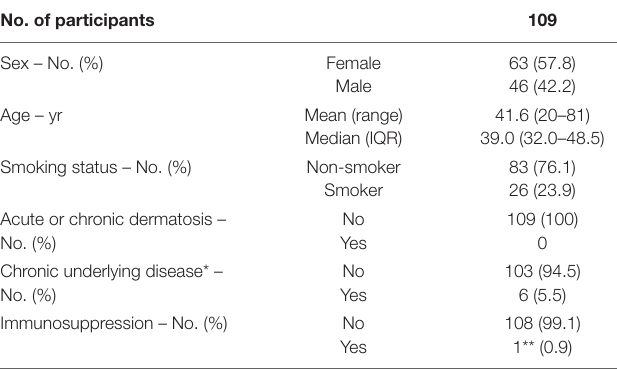
TABLE 1 | Study participants’ characteristics at